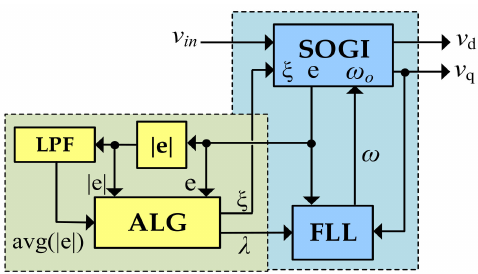
Figure 6. SOGI-FLL-EbA proposal using e, | e | and avg ( | e | ) for reducing the impact of voltage sags and swells in the estimated